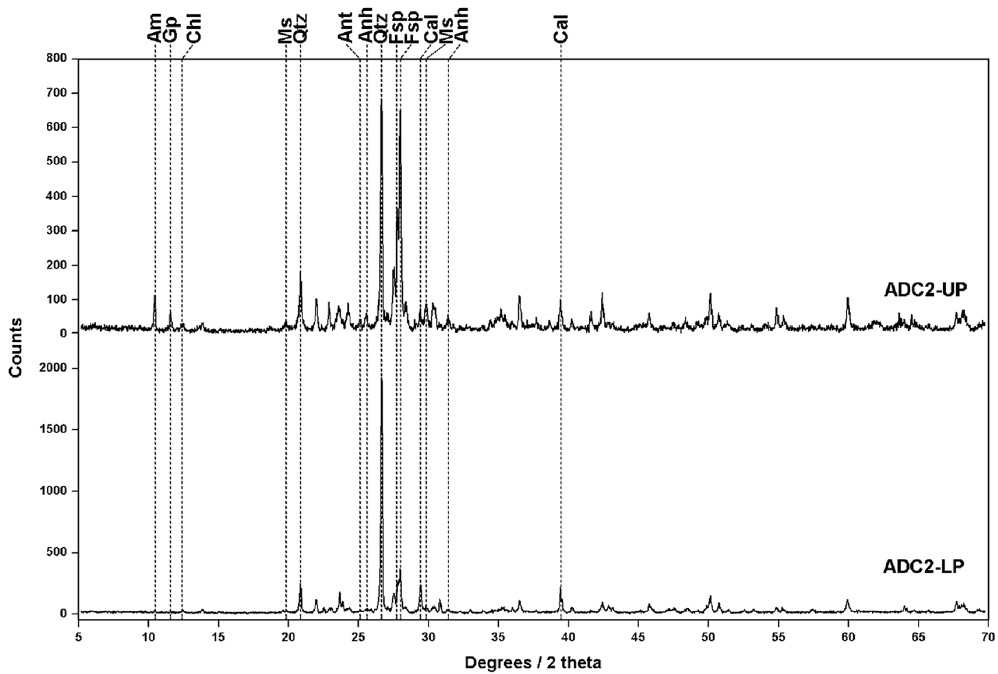
Figure 5. Diffractograms obtained from the analysis of samples ADC2-UP and -LP, revealing the presence of amphibole (Am, RUFF proxy ID: R110203), gypsum (Gy, R040029), chlorite (Chl, R060725), muscovite (Ms,